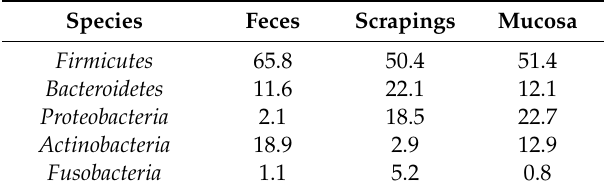
Table 3. Relative abundance for most abundant species on phylum level (%) in step 1 experiments.